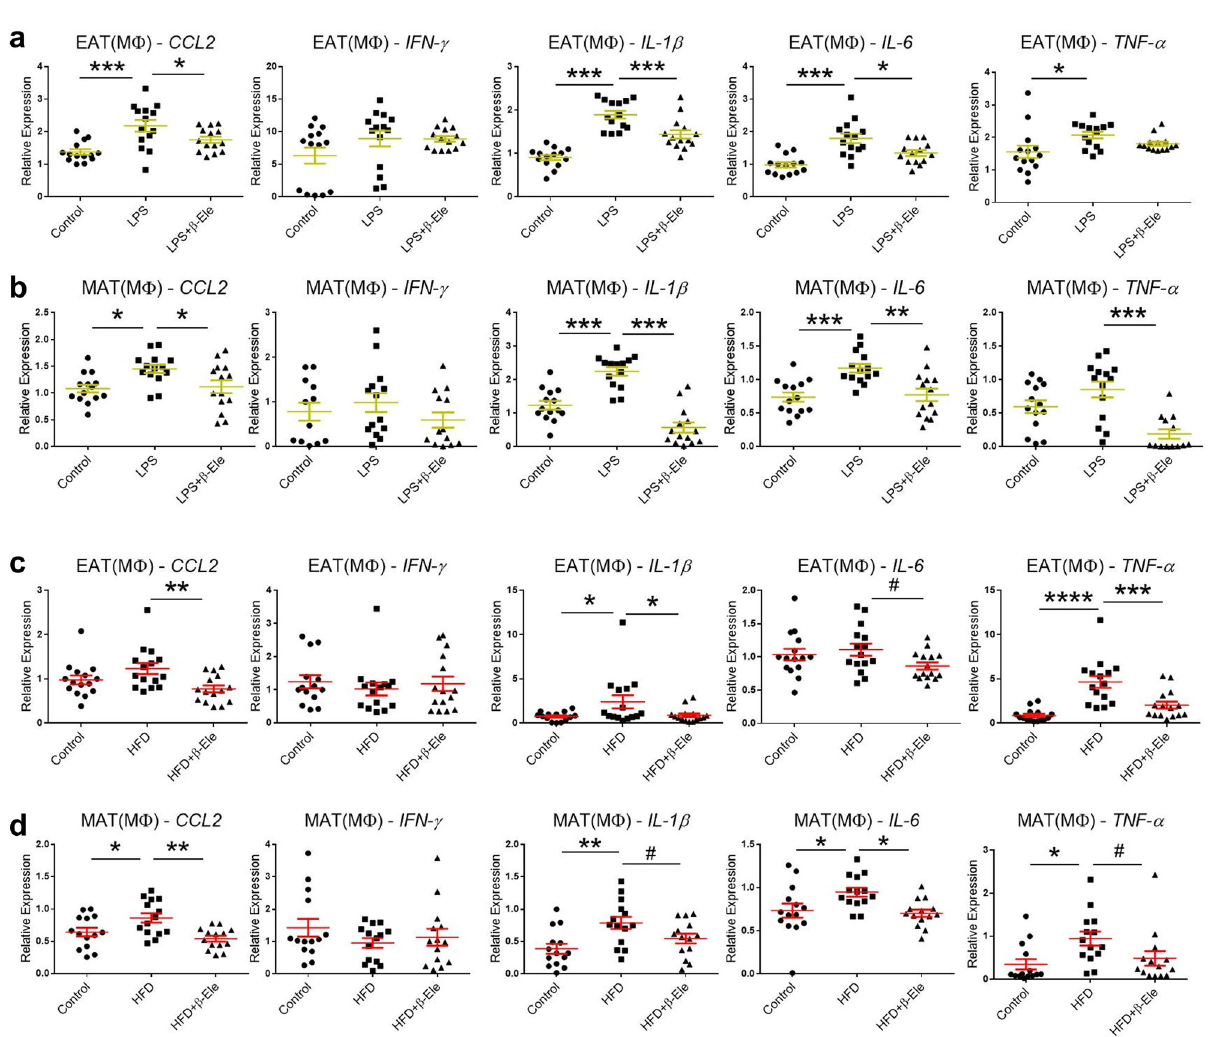
Fig. 6 Effects of β -elemene on regulating cytokine gene expression in macrophages of SVCs of white adipose tissue. a , b Effects of β -elemene on regulating cytokine gene expressions in M φ s of SVCs of white adipose tissue in vitro under LPS stimulation. Control: normal control, LPS, M φ s of SVCs cultured with LPS (10 μ g/ml), LPS + β -Ele, M φ s of SVCs cultured with LPS (10 μ g/ml) and β -elemene (10 μ g/ml). Cytokine gene expressions in M φ s of EAT-SVCs ( a n = 14) and MAT-SVCs ( b n = 14) in vitro, including CCL2, IFN- γ , IL-1 β , IL-6 , and TNF- α . Data represent individual wells. The results are shown as the mean ± SEM. * p < 0.05, ** p < 0.01, *** p < 0.001 versus LPS group assessed using one-way ANOVA followed by Dunnett ’ s multiple comparisons. The results were from three independent experiments. c , d Effects of β -elemene on regulating cytokine gene expressions in M φ s of SVCs of white adipose tissue of obese mice in vivo. Cytokine gene expressions in M φ s of SVCs of EAT ( c n = 15) and MAT ( d n = 14), in c luding CCL2, IFN- γ , IL-1 β , IL-6 , and TNF- α . Control: normal diet, HFD: high-fat diet, HFD + β -Ele: HFD-induced obese mice under treatment with β -elemene. The results are shown as the mean ± SEM. # p < 0.1, * p < 0.05, ** p < 0.01, *** p < 0.001, **** p < 0.0001 versus HFD group assessed using one-way ANOVA followed by Dunnett ’ s multiple comparisons. The results present data from three independent experiments with similar decreased, while the levels of unphosphorylated ERK, JNK, and nuclear factor-kappa B (NF- κ B), which is upstream and down- p38 MAPK showed no signi fi cant changes, suggesting that β - stream of the MAPK pathways respectively, were also obviously elemene, especially with high concentrations, regulated LPS- decreased by β -elemene intervention as shown in Fig. 8e, f and induced MAPK signaling in RAW 264 cells. Furthermore, the Supplementary Fig. 6. All the original images of western blotting expression of myeloid differentiation factor 88 (MyD88) and were shown in the Supplementary Fig. 7.